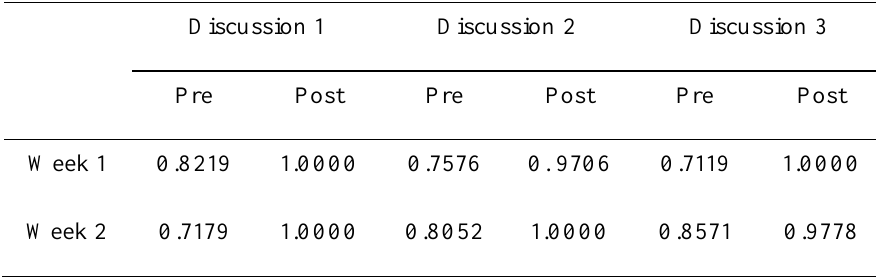
Inter-Rater Reliability for Module 6